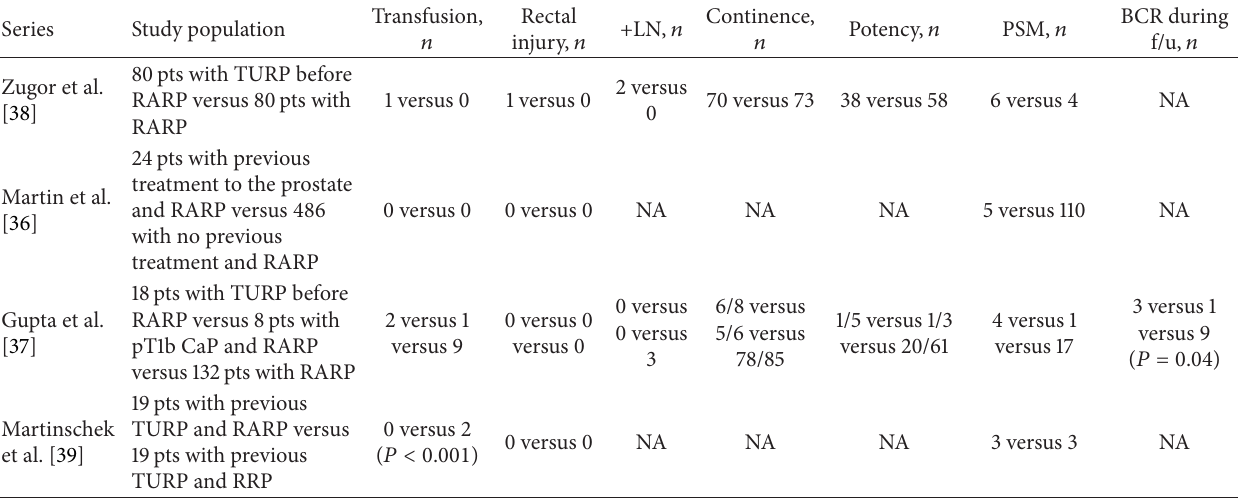
Table 4: Oncologic and functional outcomes in clinical series consisting of patients who underwent RARP after prostate surgery. Transfusion, Series Study population 𝑛